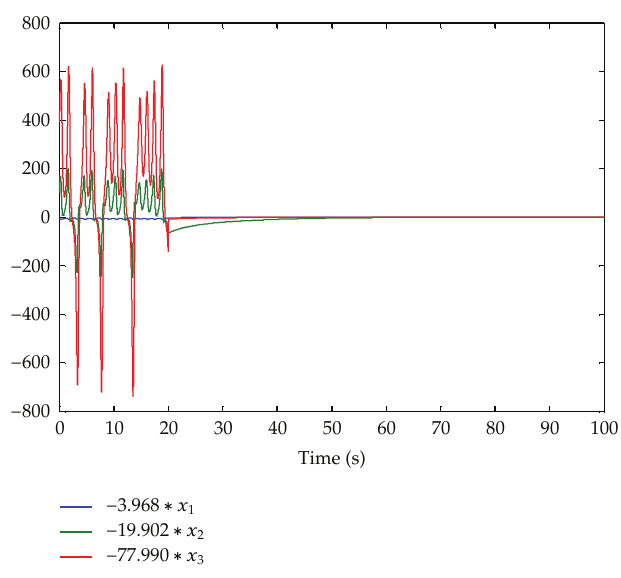
Figure 4: Time response of control input u (cid:2) t (cid:3)